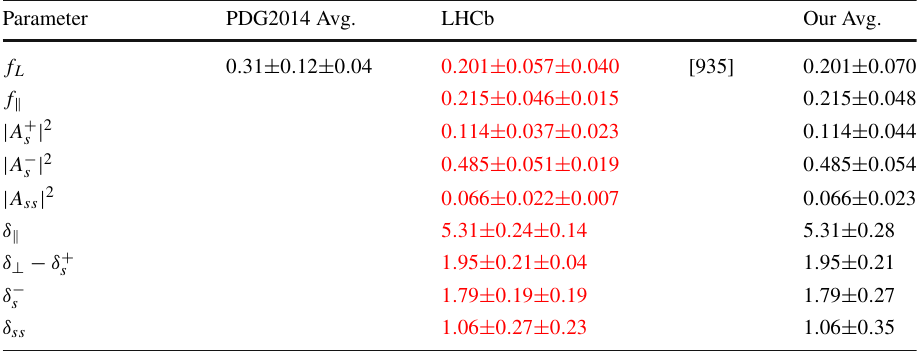
∗ 0 decays. Where values are shown in red